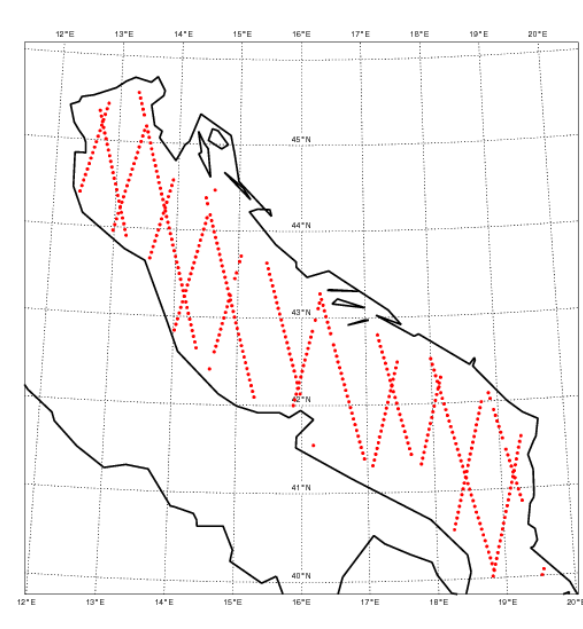
Fig. 7. Ground tracks of the ENVISAT altimeter in the Adriatic Figure 7 – Ground tracks of the ENVISAT altimeter in the Adriatic Sea. Each dot corresponds to Sea. Each dot corresponds to one wave height one wave height datum.